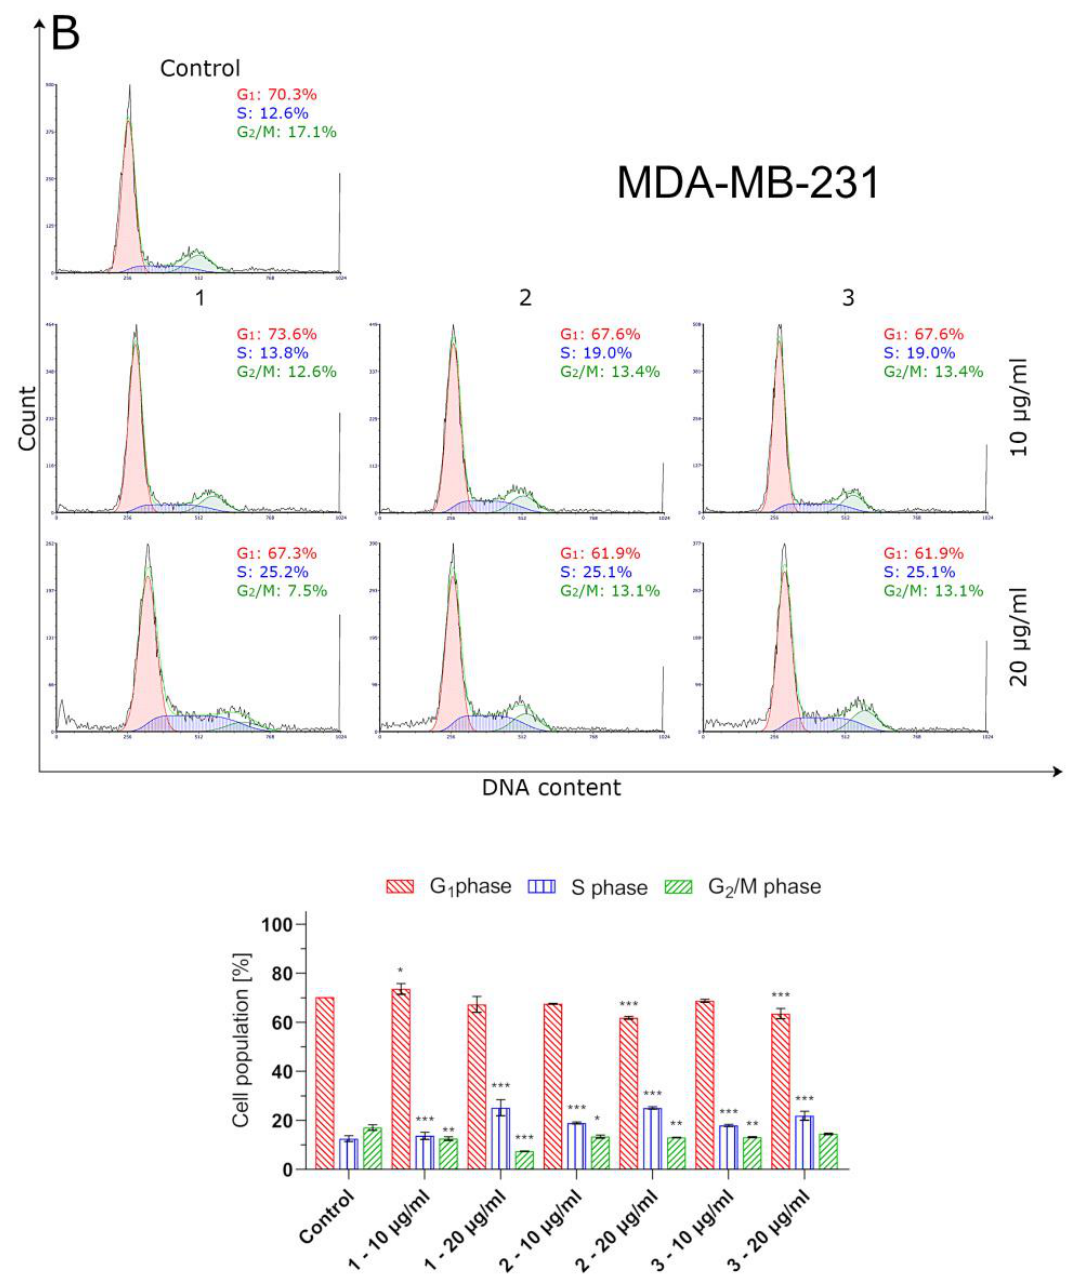
Figure 6. Cell cycle analyses of MCF-7 ( A ) and MDA-MB-231 ( B ) breast cancer cells incubated for 24 h with compounds 1 – 3 . The compounds were tested at the following concentrations: 1 (10 µ g/mL/23.83 µ M and 20 µ g/mL/47.66 µ M), 2 (10 µ g/mL/22.75 µ M and 20 µ g/mL/45.50 µ M), 3 (10 µ g/mL/23.78 µ M and 20 µ g/mL/47.56 µ M) andetoposide(10 µ g/mL/17 µ M and 20 µ g/mL/34 µ M). Mean percentage values from three independent experiments (n = 3) performed in duplicate are presented. * p < 0.05 vs. control group, ** p < 0.01 vs. control group, *** p < 0.001 vs. control group.